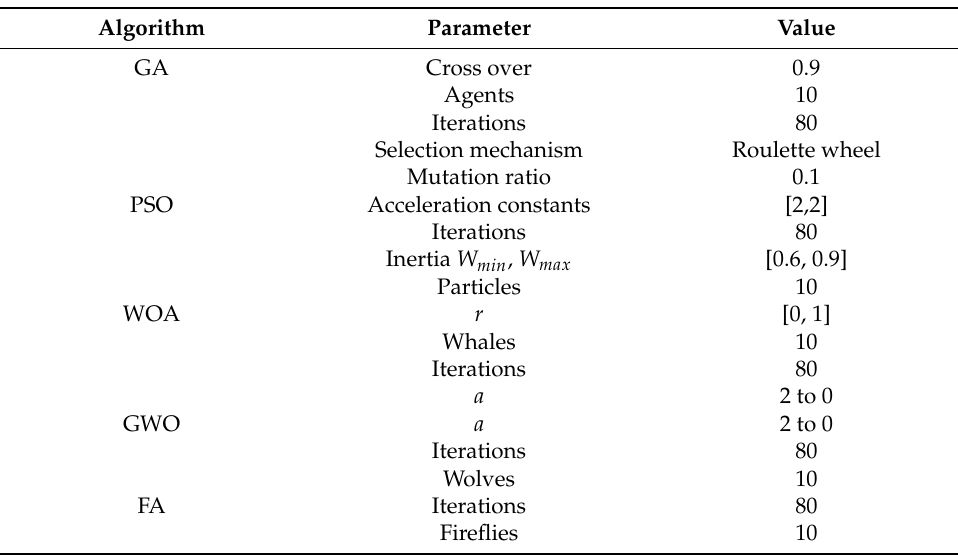
Table 3. Configuration parameters of the optimization